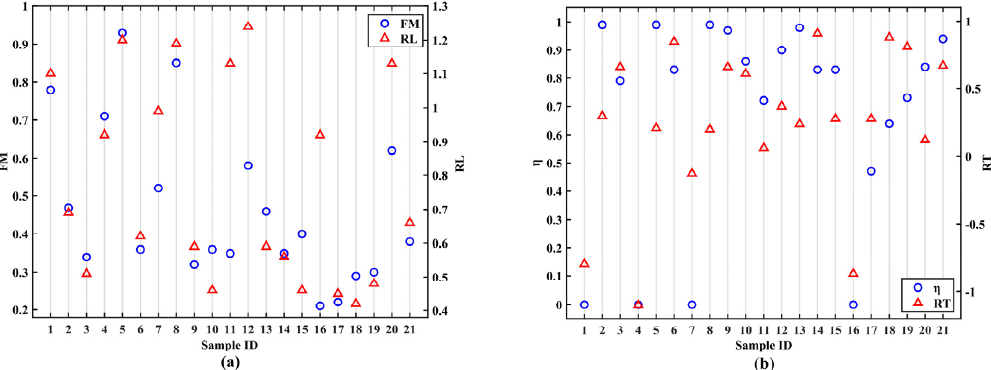
Figure 11. Aerodynamic characteristics of rotor samples. ( a ) Hover flight. ( b ) Forward flight. Those results can lead to K values as shown in Figure 12, and the K values are normalized to show the quality of design variables at different levels.